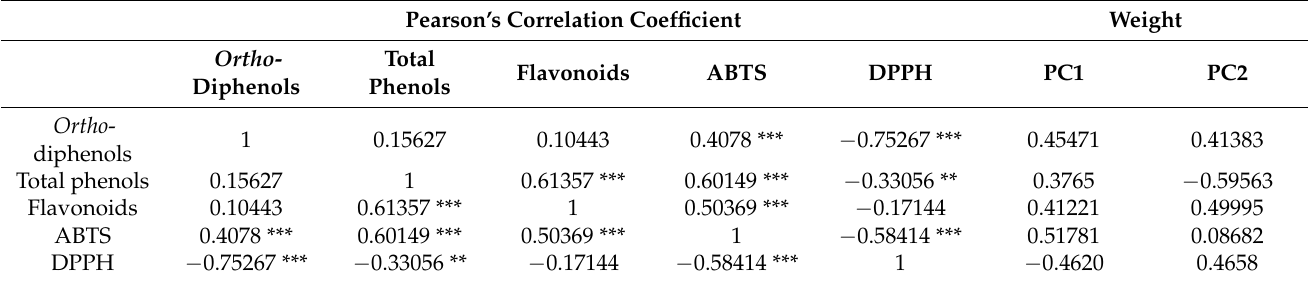
Table 4. Pearson’s correlation coefficient test (r) and weight of each variable for the main components. Pearson’s Correlation Coefficient